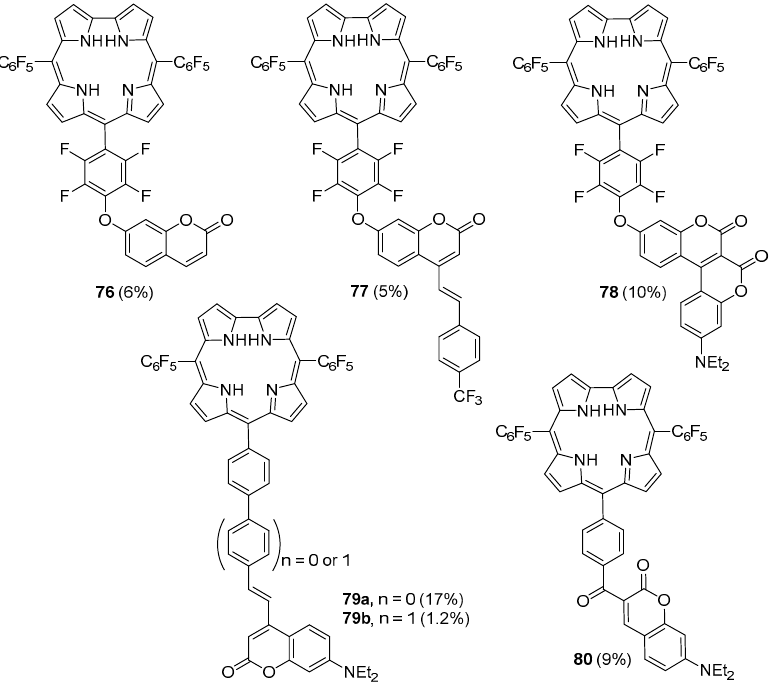
Figure 5. Coumarin–corrole dyads obtained by the [2 + 1] strategy [113].